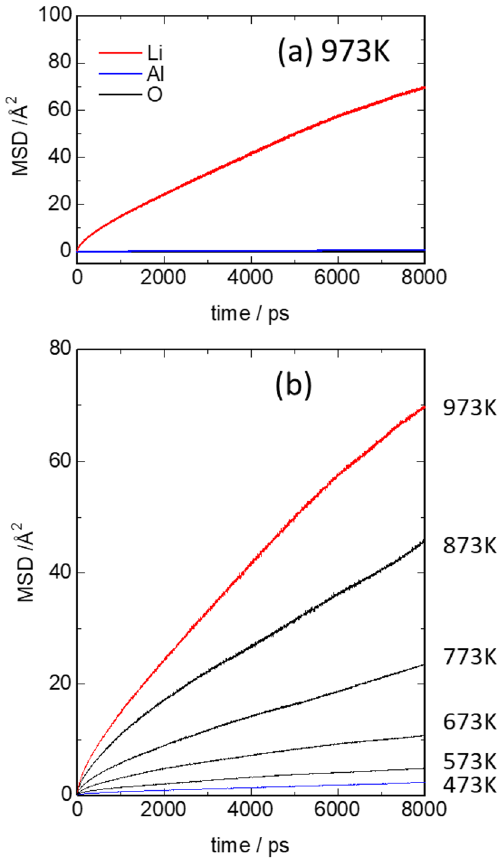
Figure 5. Mean square displacement (MSD) plots obtained by force field molecular dynamics (FFMD) calculations for Model 4, which contains a 4.5 mol% excess of Li ions and 1.5% deficiency (vacancies) of Al ions. ( a ) MSD plots of Li, Al, and O at 973 K. ( b ) MSD plots of Li ions at 473–973